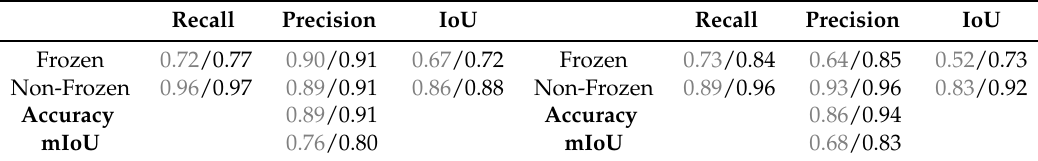
Table 11. MODIS leave one winter out results. The numbers are shown in A/B format where A and B represent the outcomes using RBF and linear kernels, respectively. The better kernel for a given experiment is shown in black, worse kernel in grey. Left is winter 16–17, right is winter 17–18. Recall Recall